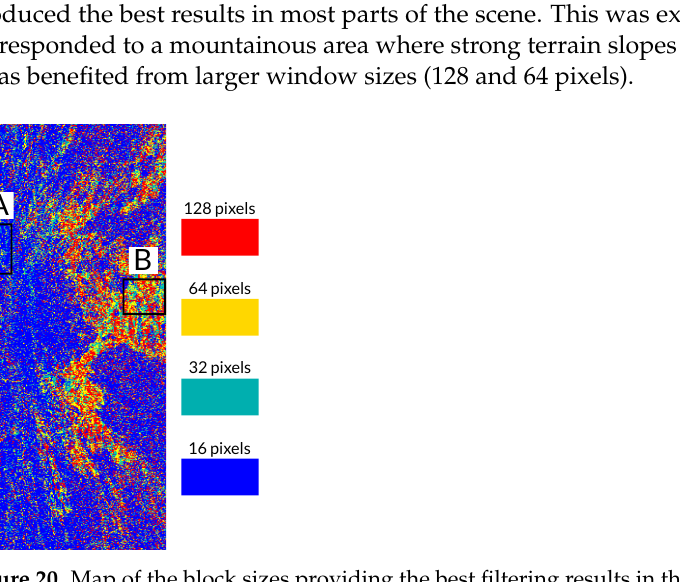
Figure 20. Map of the block sizes providing the best filtering results in the processed area. Region A is located near the summit area of Mount Etna. Region B is a flat